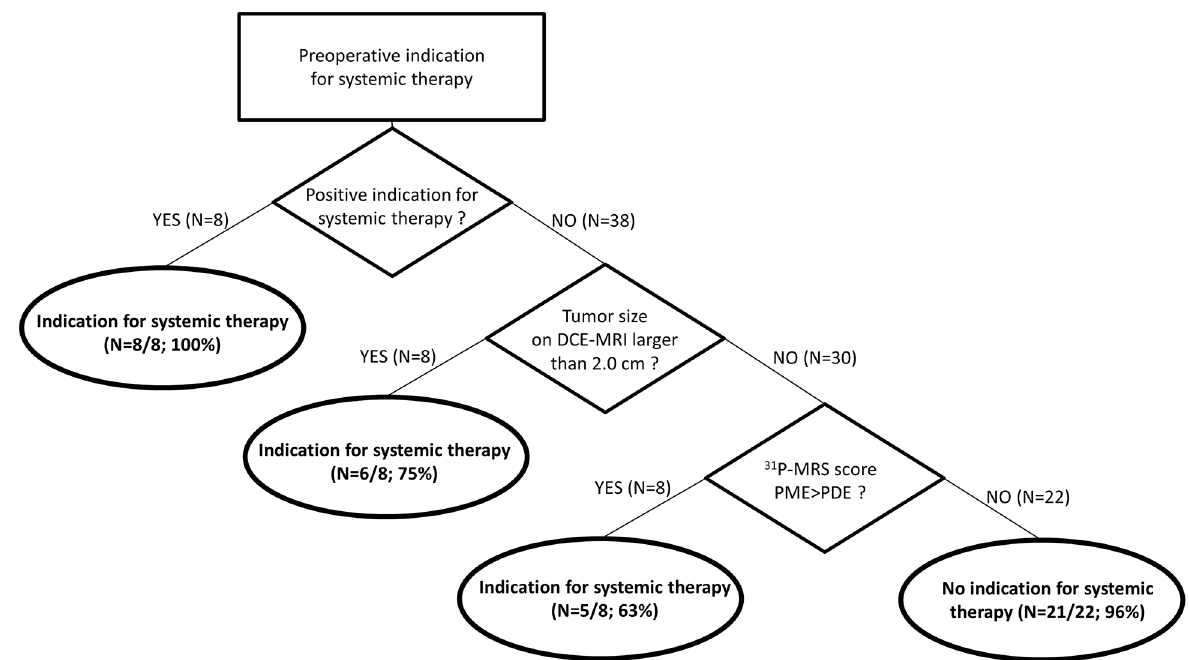
Fig 1. A decision tree was createdto establish a preoperative indication for systemictherapy, taking the postoperative indication as the golden standard. 7T DCE-MRI = 7 tesla dynamiccontrast-enhancedmagneticresonance imaging. 31 P -MRS = 31-Phosphorus MR spectroscopy. PME = Phosphomonoesters. PDE = Phosphodiesters.